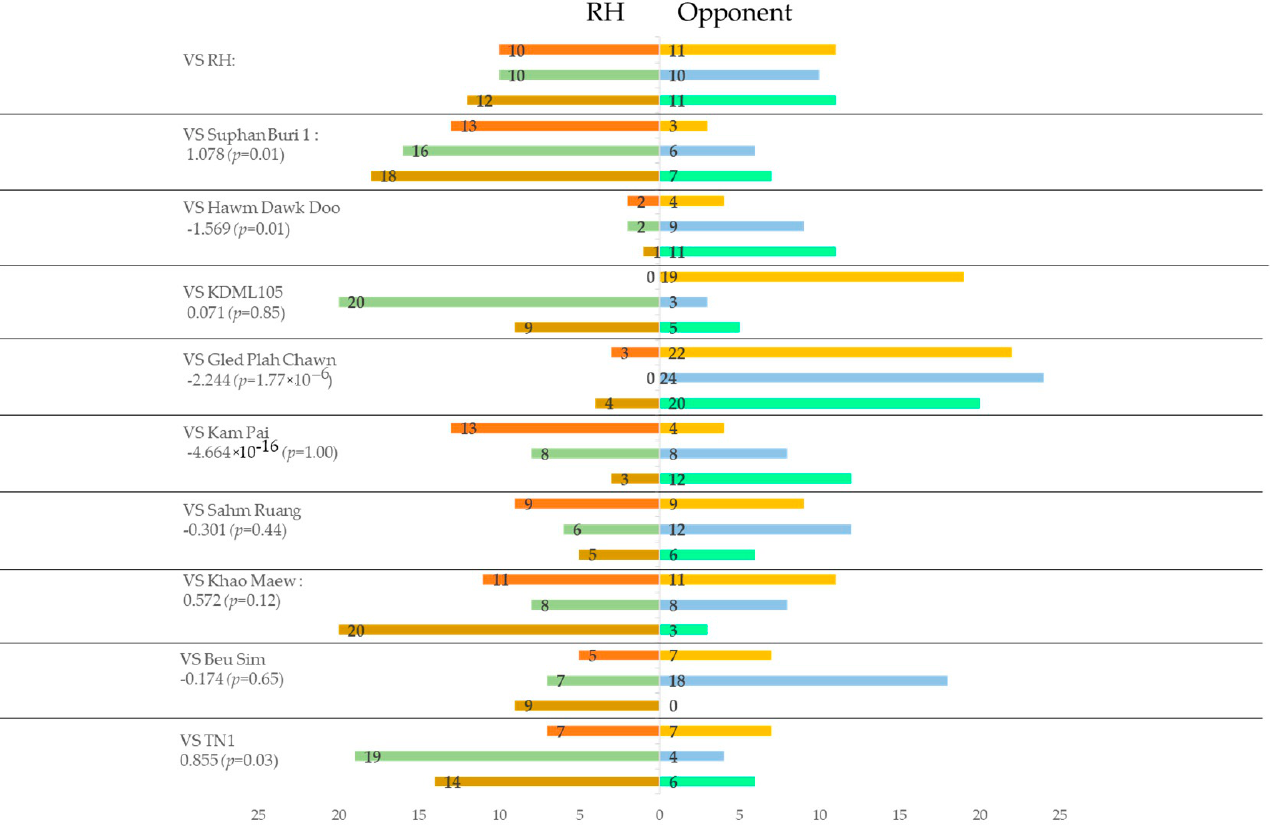
Figure 3. Relative olfactory preferences of BPH for volatiles from rice plants of RH variety to the others determined by two–choice tests using potted plants with BPH infestation.